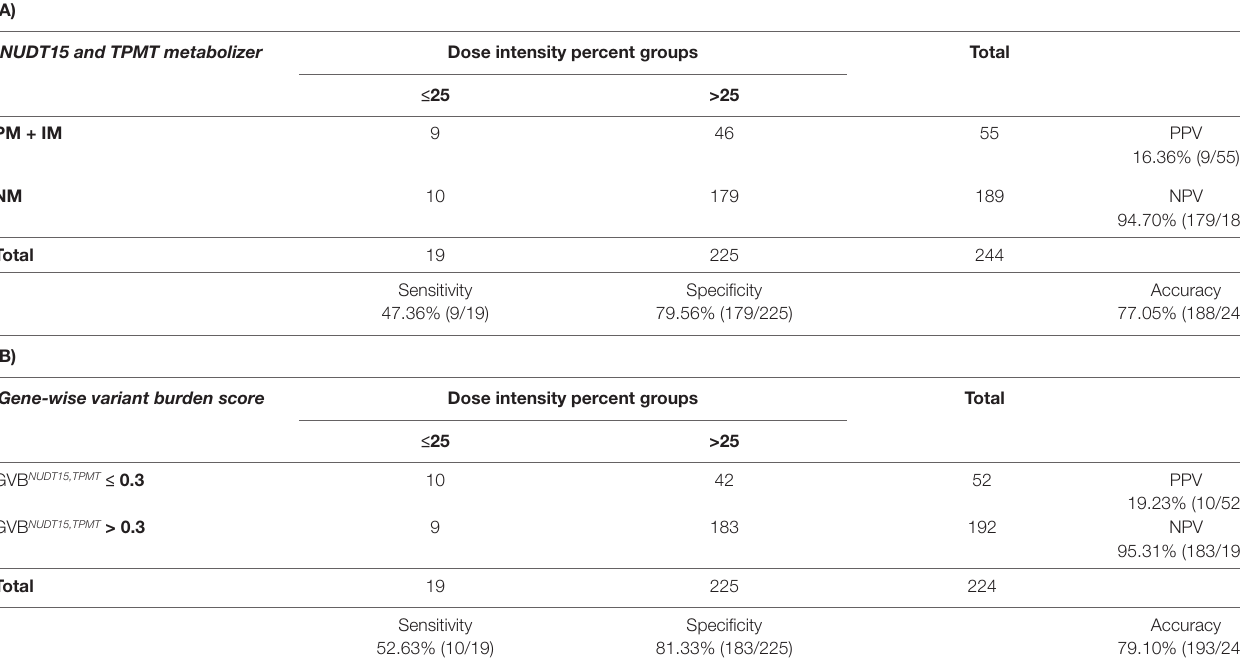
TABLE 4 | Comparison of star allele-based haplotyping versus gene-wise variant burden (GVB NUDT15 , TPMT ) analyses for 6-mercaptopurine intolerance measured by last- cycle dose intensity percent in ALL. Diagnostic accuracy table of (A) star allele-based haplotypes and dose intensity percent groups and (B) gene-wise variant burden score and dose intensity percent